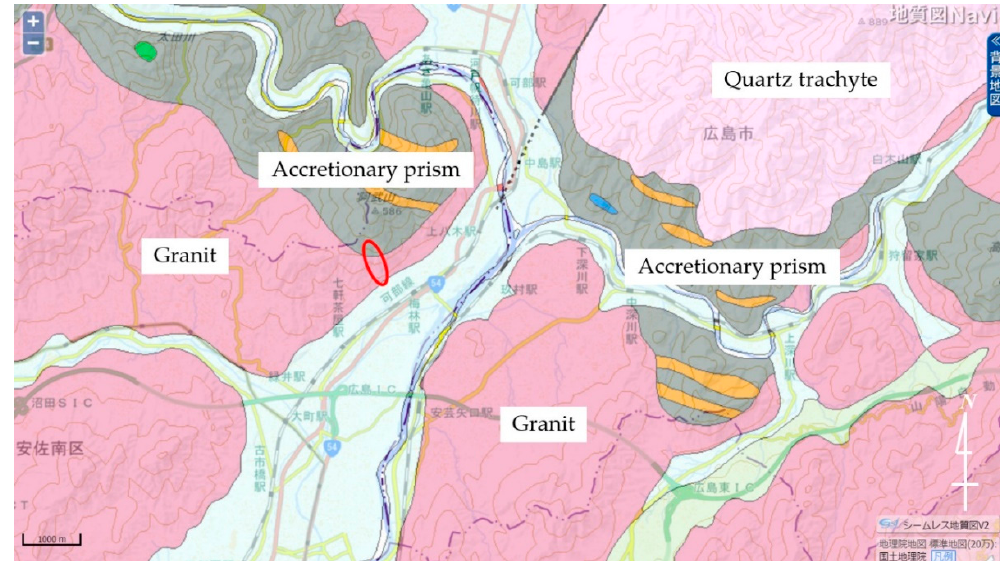
Figure 4. Geological map of the area around Asaminami, Hiroshima, Japan (Souce: The National Institute of Advanced Industrial Science and Technology, Japan). The red circle indicates the research area.